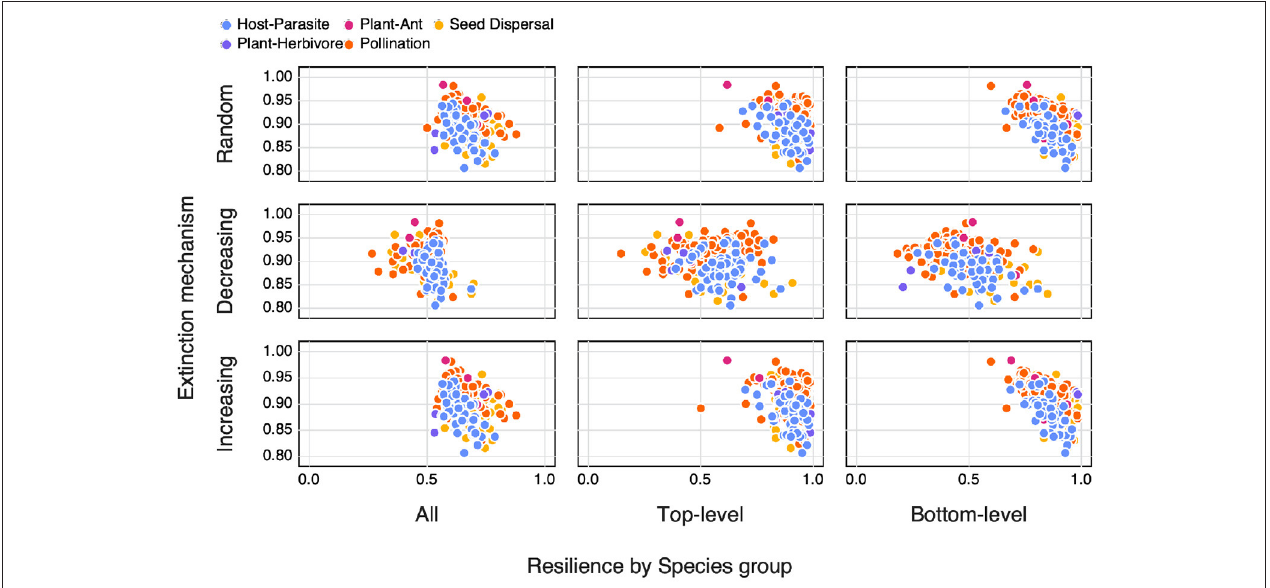
FIGURE 5 | The relationship between SVD entropy and the area under an extinction curve (as a proxy for resilience to extinction) for both different extinction mechanisms (Random = the removal of a random species, Decreasing = the removal of species in order of decreasing number of interactions (i.e., most to least number of interactions), Increasing = the removal of species in order of increasing number of interactions) as well as along different dimensions (species groups) of the network (All = any species, Top-level = only top-level species, and Bottom-level = only bottom-level species) colours indicate the different interaction types of the networks.